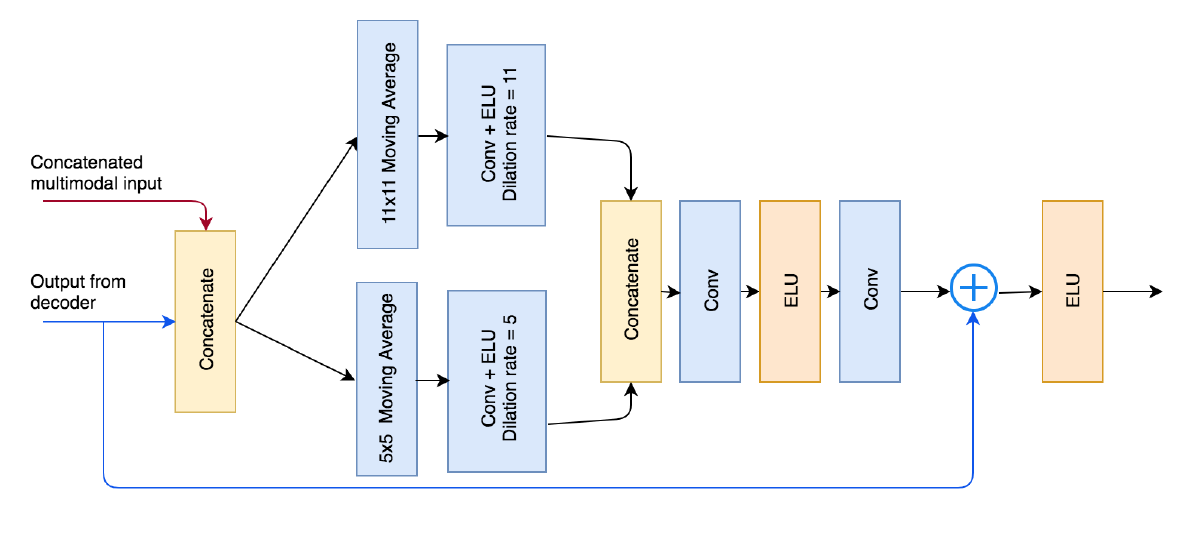
Figure 2. Spatial correlation correction block